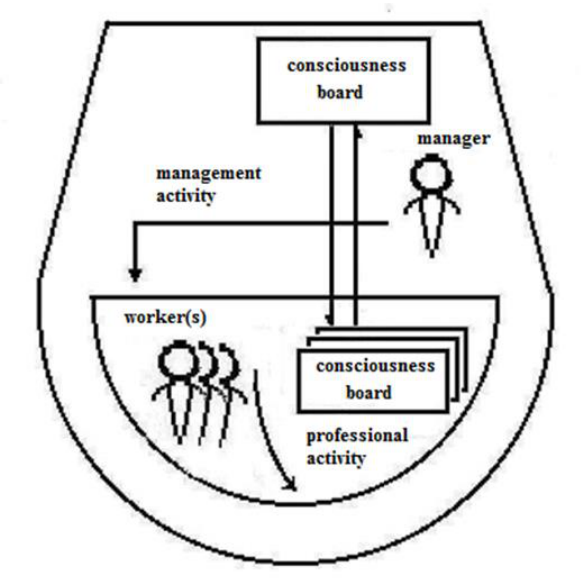
Figure 2. Classical organizational-technical system scheme (by G. P.